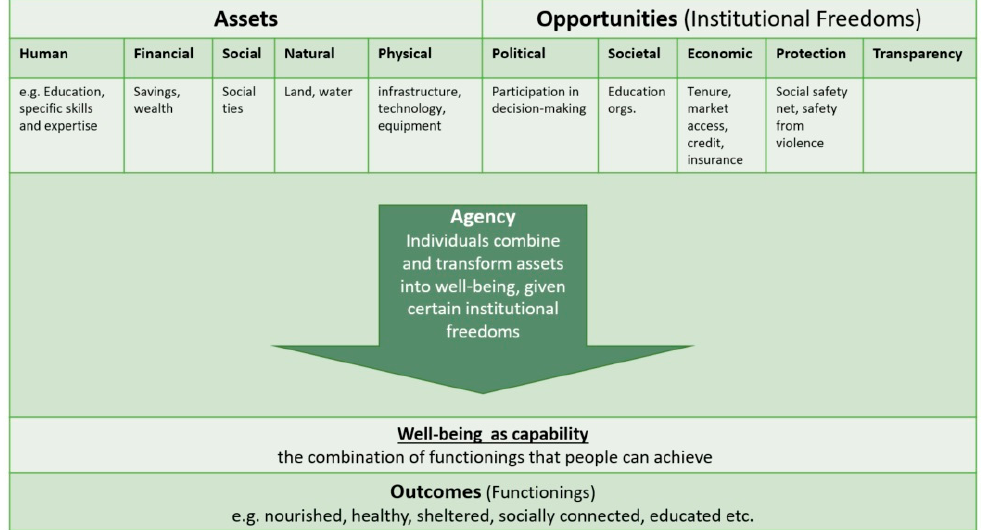
Figure 1. Representation of the process of improving an individual’s well-being, understood in terms of assets, opportunities, functionings and capability (adapted from [38]).